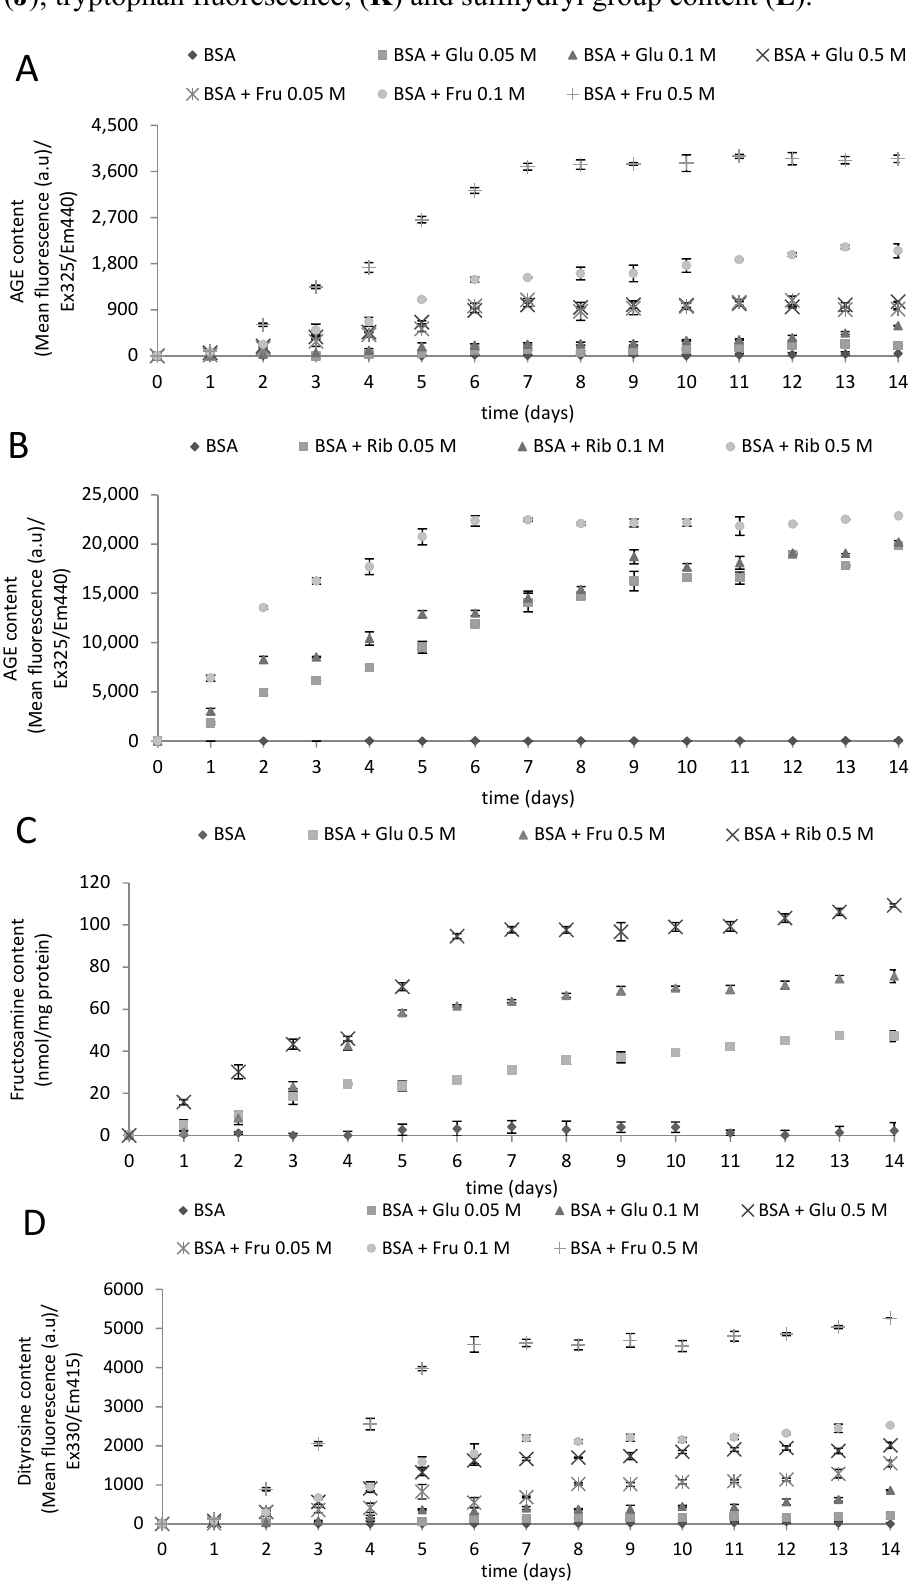
Figure 1. The time course of the glycoxidation of BSA incubated at 37 °C for 14 days with 0.05, 0.1 and 0.5 M glucose (Glu), fructose (Fru) and ribose (Rib): AGE fluorescence ( A , B ); fructosamine content ( C ); dityrosine content ( D , E ); N '-formylkynurenine content ( F , G ); N-formylkynurenine content ( H , I ); advanced oxidation protein products (AOPP) content ( J ); tryptophan fluorescence; ( K ) and sulfhydryl group content ( L ).